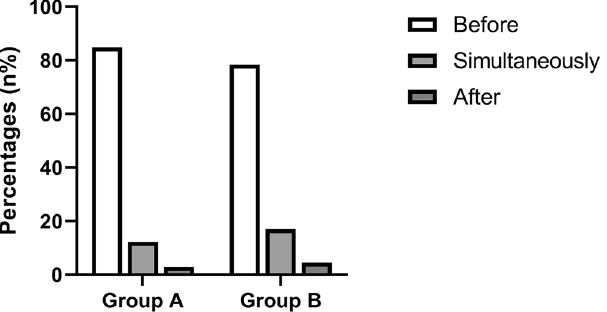
Figure 4. Chronological relationship of complication of AR/CRS and IgG4-RD diagnosis in IgG4-RD patients. In Group A (IgG4-RD complicated with AR), 84.83% patients had nasal symptoms before IgG4-RD